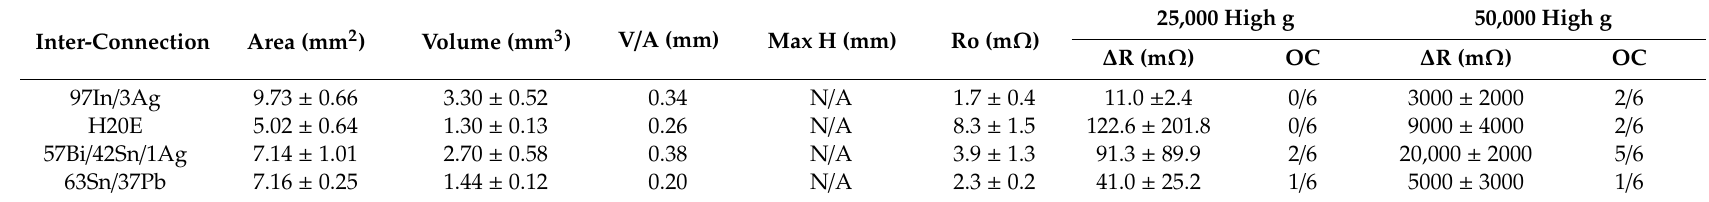
Table 5. High g testing results for copper CB230 conductive